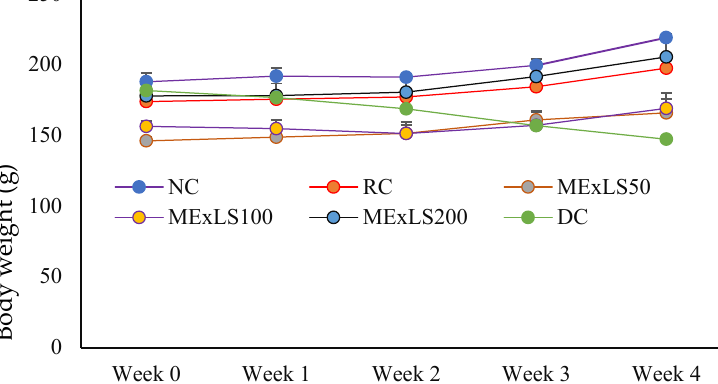
Figure 3. Changes of BW on intervention of ME X LS in Albino rats over four weeks ( n = 5). Data are expressed as mean ± SEM. Data were analyzed by one way analysis of variance (ANOVA) using the statistical software SPSS followed by a Tukey’s Post Hoc test for significance. p < 0.05 was considered